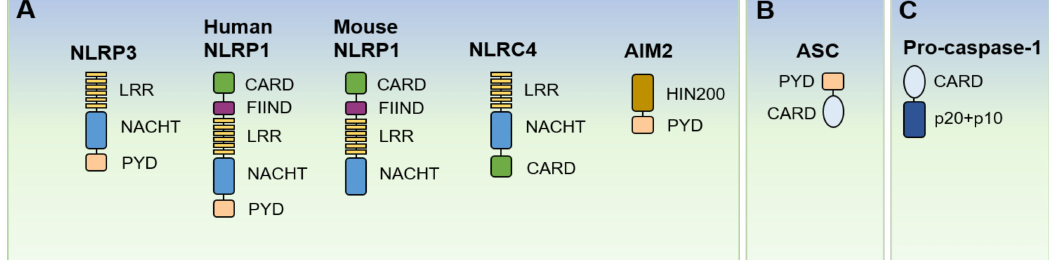
Figure 2. Schematic structure of NLRPs, ASC, and caspase-1. ( A ) Structures of inflammasome sensors NLRP3, NLRP1, NLRC4, and AIM2. ( B ) Structures of inflammasome adaptor protein ASC and ( C ) inflammasome e ff ector pro-caspase-1. LRR; leucine-rich repeat domain, NACHT (or NBD); nucleotide-binding domain, PYD; pyrin domain, CARD; caspase recruitment domain family, FIIND; function-to-find domain, HIN200; 200-amino acid